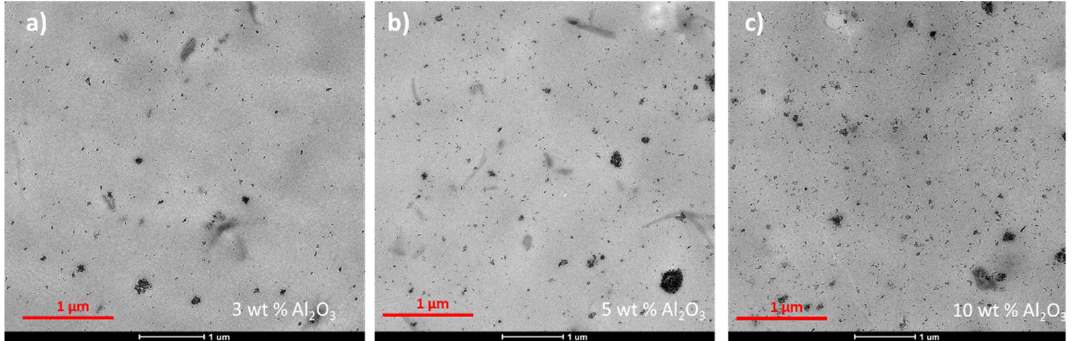
Figure 9. Binarized TEM micrographs for PHBH nanocomposites containing ( a ) 3 wt.%, ( b ) 5 wt.% and ( c ) 10 wt.% of alumina nanoparticles. Table 2. Number of measured particles, particle density, average particle size (area) and the corre- sponding standard error of the PHBH nanocomposites prepared by melt blending as a function of the alumina content, as computed by Automated Image Analysis.